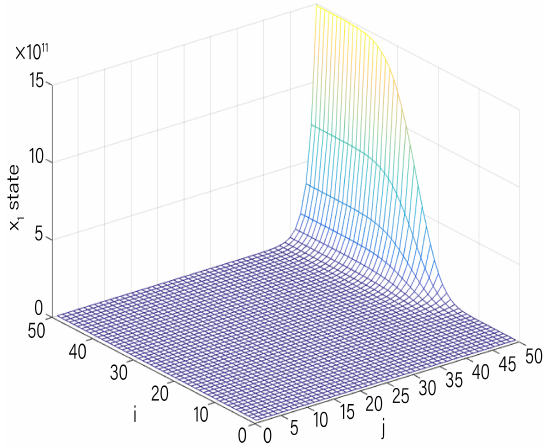
Figure 2. Open-loop state space response of x 1 ( i , j )